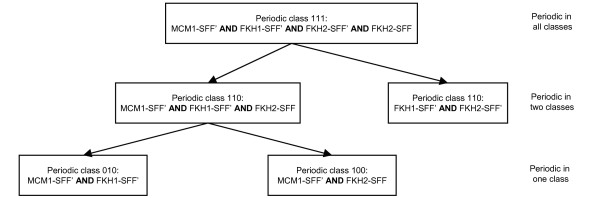
Regulatory hierarchy. A part of the hierarchy formed from combinations of cis-regulatory descriptors that are subsets of the combination MCM1-SFF' FKH1-SFF' FKH2-SFF' FKH2-SFF. Note that the hierarchical structure of the combinations are matched by a hierarchical structure of the corresponding class labels (i.e. the classes from which each combination was induced).